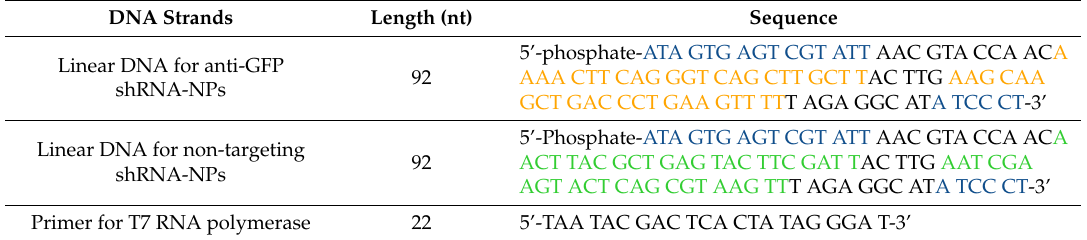
Table 1. DNA sequences for synthesizing anti-GFP, and negative control short hairpin RNA nanoparticles (shRNA-NPs). The complementary DNA sequence for the promoter region of T7 RNA polymerase is shown in blue, and the primer for T7 RNA polymerase binds to the blue region to form the promoter region of T7 RNA